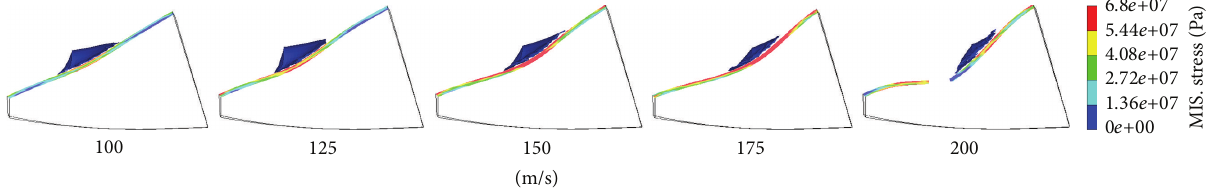
Figure 9: Impact response of windshield with increase in impact velocity.